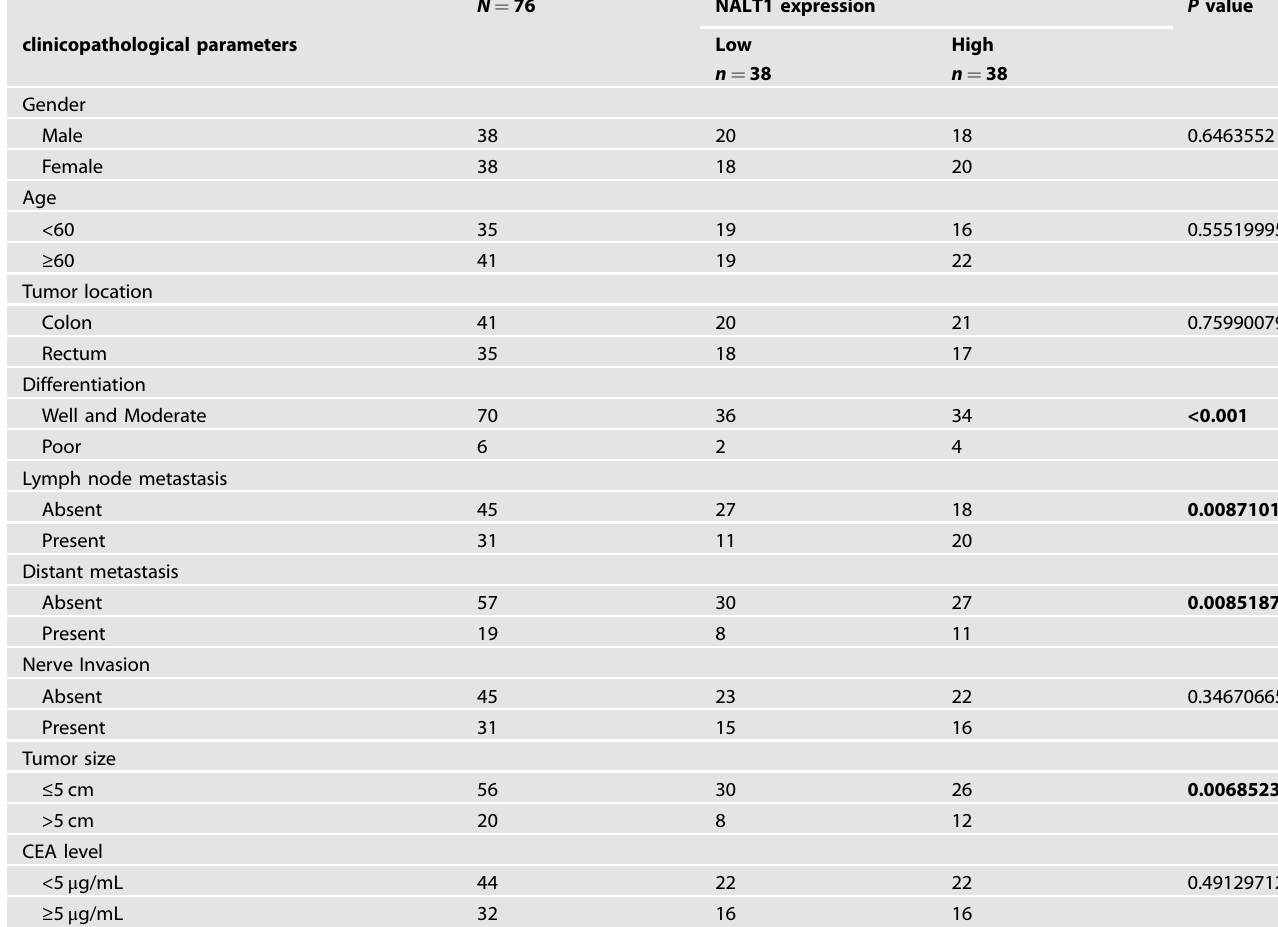
Table 1. Correlation between the expression levels of NALT1 and clinicopathological features in 76 CRC